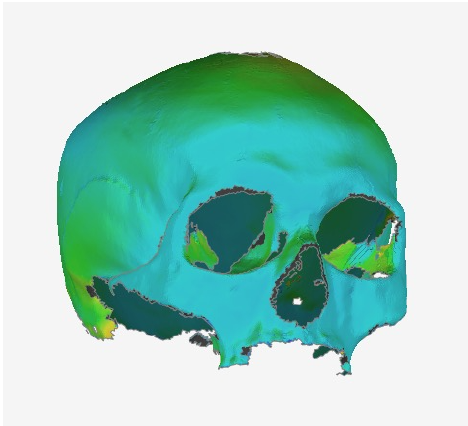
Figure 9. Comparison of SLA copy with parent 3D